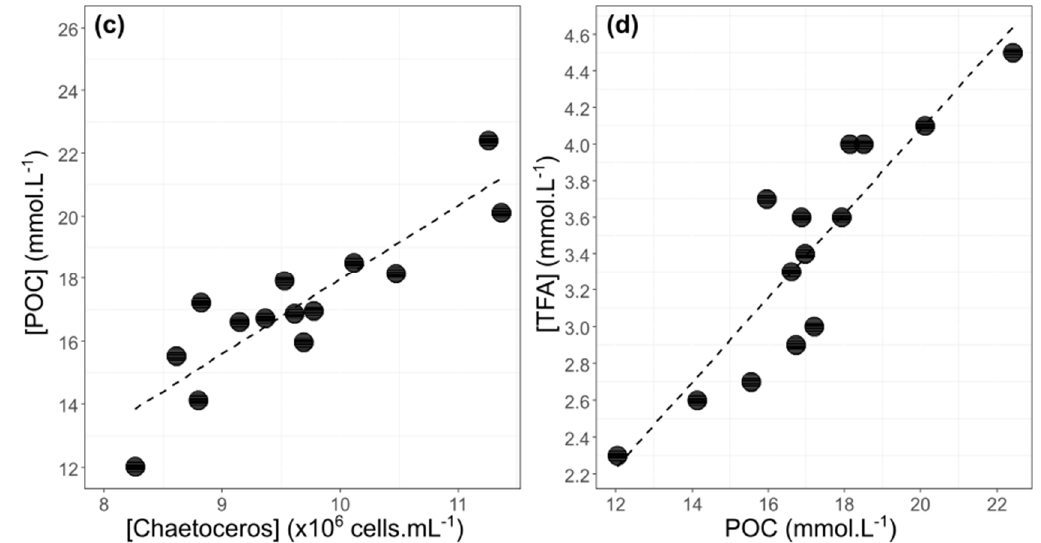
Figure 4. Dynamics of Particulate Organic Carbon concentration ( a ) and of Total Fatty Acids concentration ( b ) for the two enriched balloons Cm1 and Cm2 (Cm = Chaetoceros muelleri ) (mean ± SD; n = 3). The blue line corresponds to increasing trend between t 0 and t 24 (POC: y = 0.27x + 14, R 2 = 76% p -value < 0.001; TFA: y = 0.08x + 2.5, R 2 = 93% p -value < 0.001). POC concentration relationships with algae concentration ( c ) (eq: y = 2.4x − 5.7 R 2 = 79%, p -value < 0.001) and with total fatty acid concentration ( d ) (eq: y = 0.23x − 0.5, R 2 = 80%, p -value < 0.001) (mean; n = 3). Points below 8 × 10 6 cells·mL −1 are not included in the linear regression and are considered as outliers (corresponding to t 0.5 and t 1 in Figure 3).